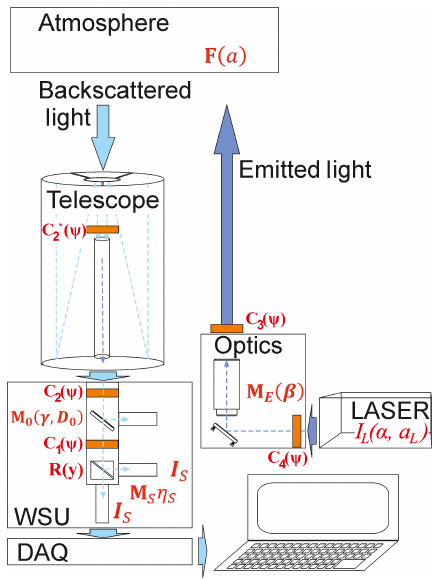
Figure 1. Schematics of a lidar system. Emission block is the laser and the emission optics; receiving block is the telescope, wave- length separation unit (WSU) and data acquisition (DAQ) block. Mueller–Stokes notations (red) for specific optical components used later in the study. Possible positions of the calibration units (orange) with respect to the optical